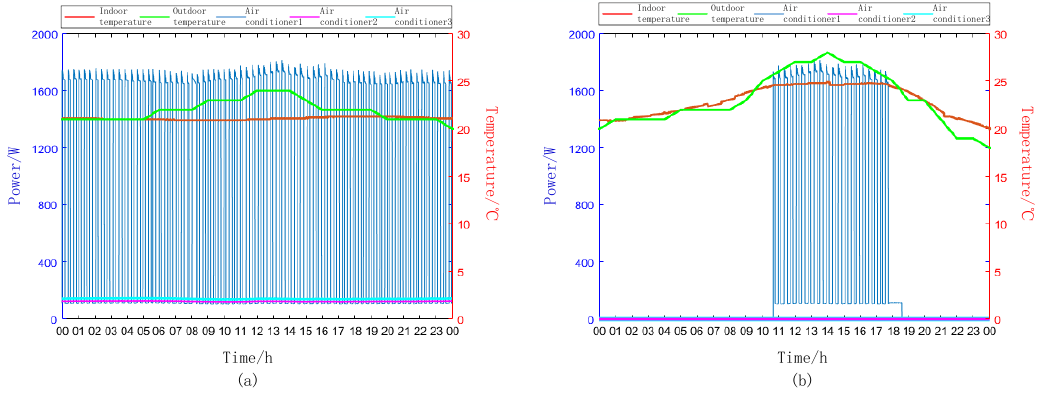
Figure 8. Future Internet 2019 , 11 , x FOR PEER REVIEW